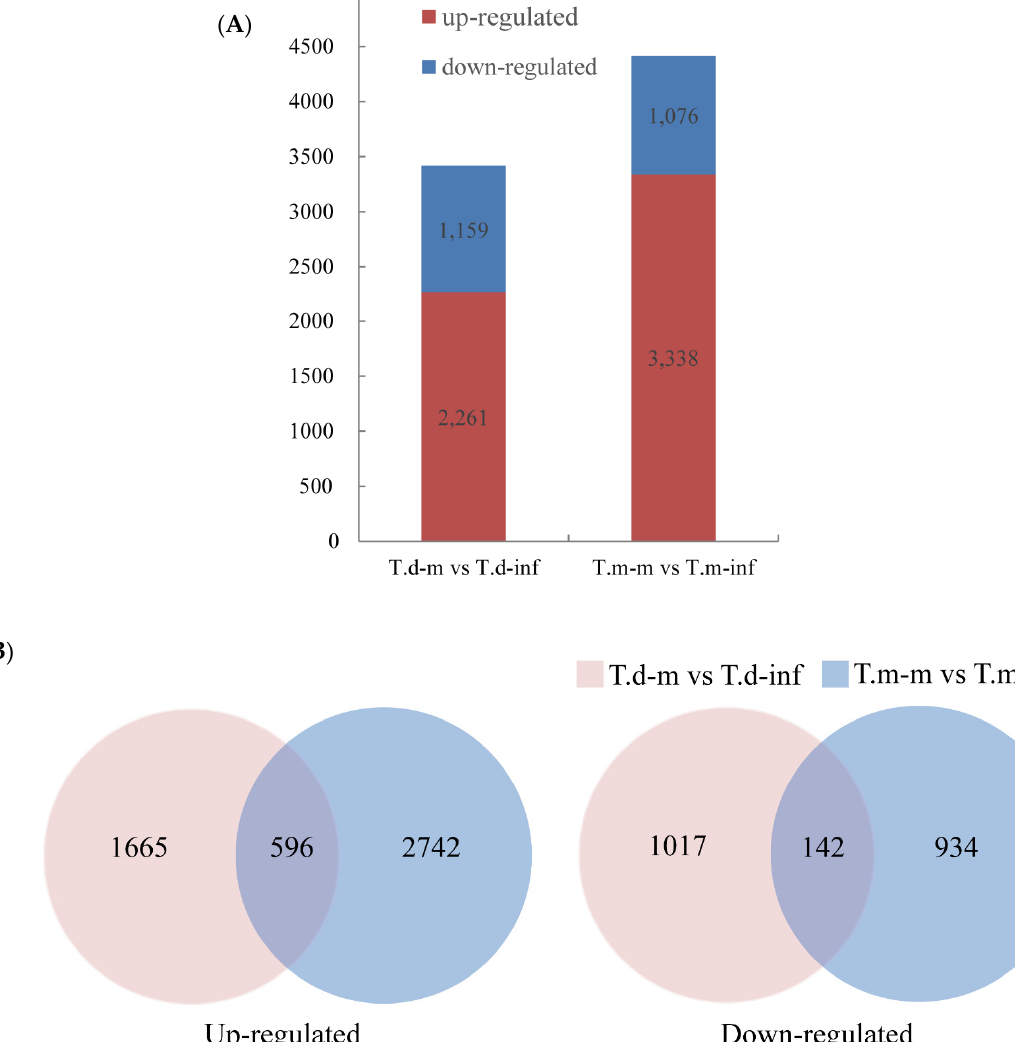
Figure 3. Differential gene expression in resistant T. distichum and susceptible T. mucronatum after fungal infection. ( A ) Histogram representing variation of DEGs after inoculation of P. maculans in resistant/susceptible plants. ( B ) Venn diagram represent DEGs in upregulated and downregulated groups. T.m -m: leaves of T. mucronatum with water treatment; T.m -inf: leaves of T. mucronatum with the fungal P. maculans infection; T.d -m: leaves of T. distichum with water treatment; T.d -inf: leaves of T. distichum with the fungal P. maculans infection.